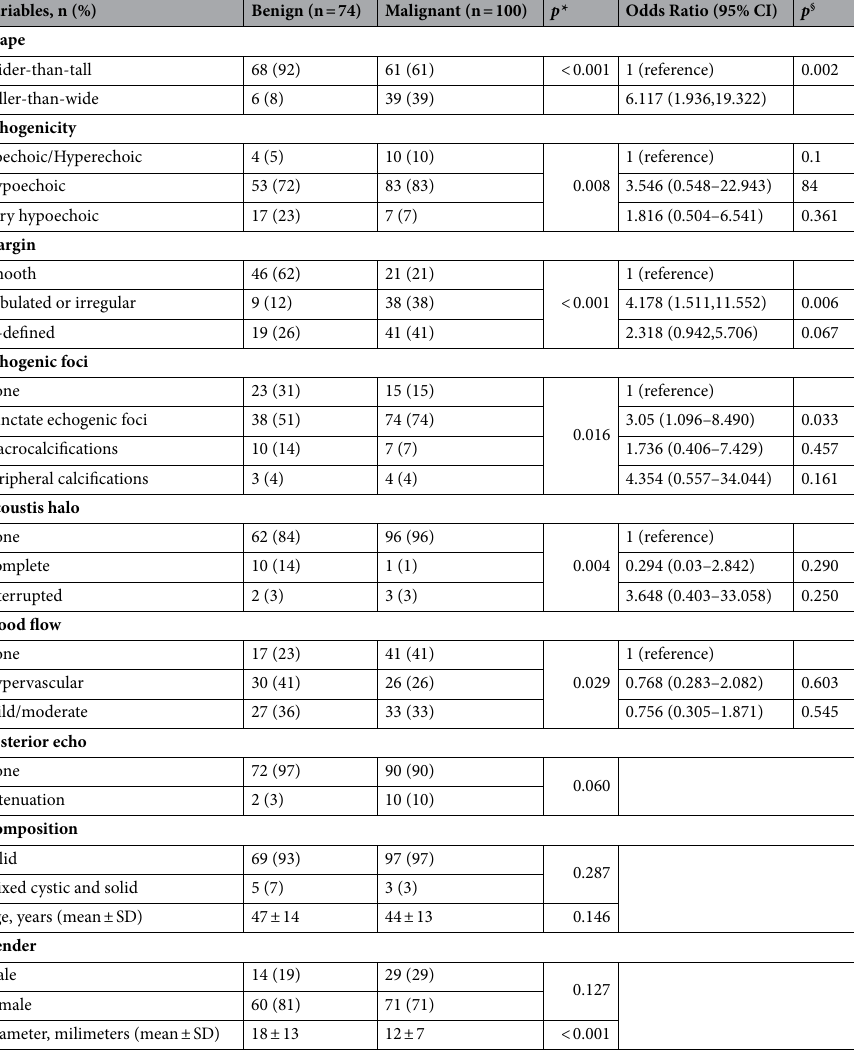
Table 1. Clinical and ultrasonic features of the thyroid nodules. *By chi-square test. § By multiple logistic regression